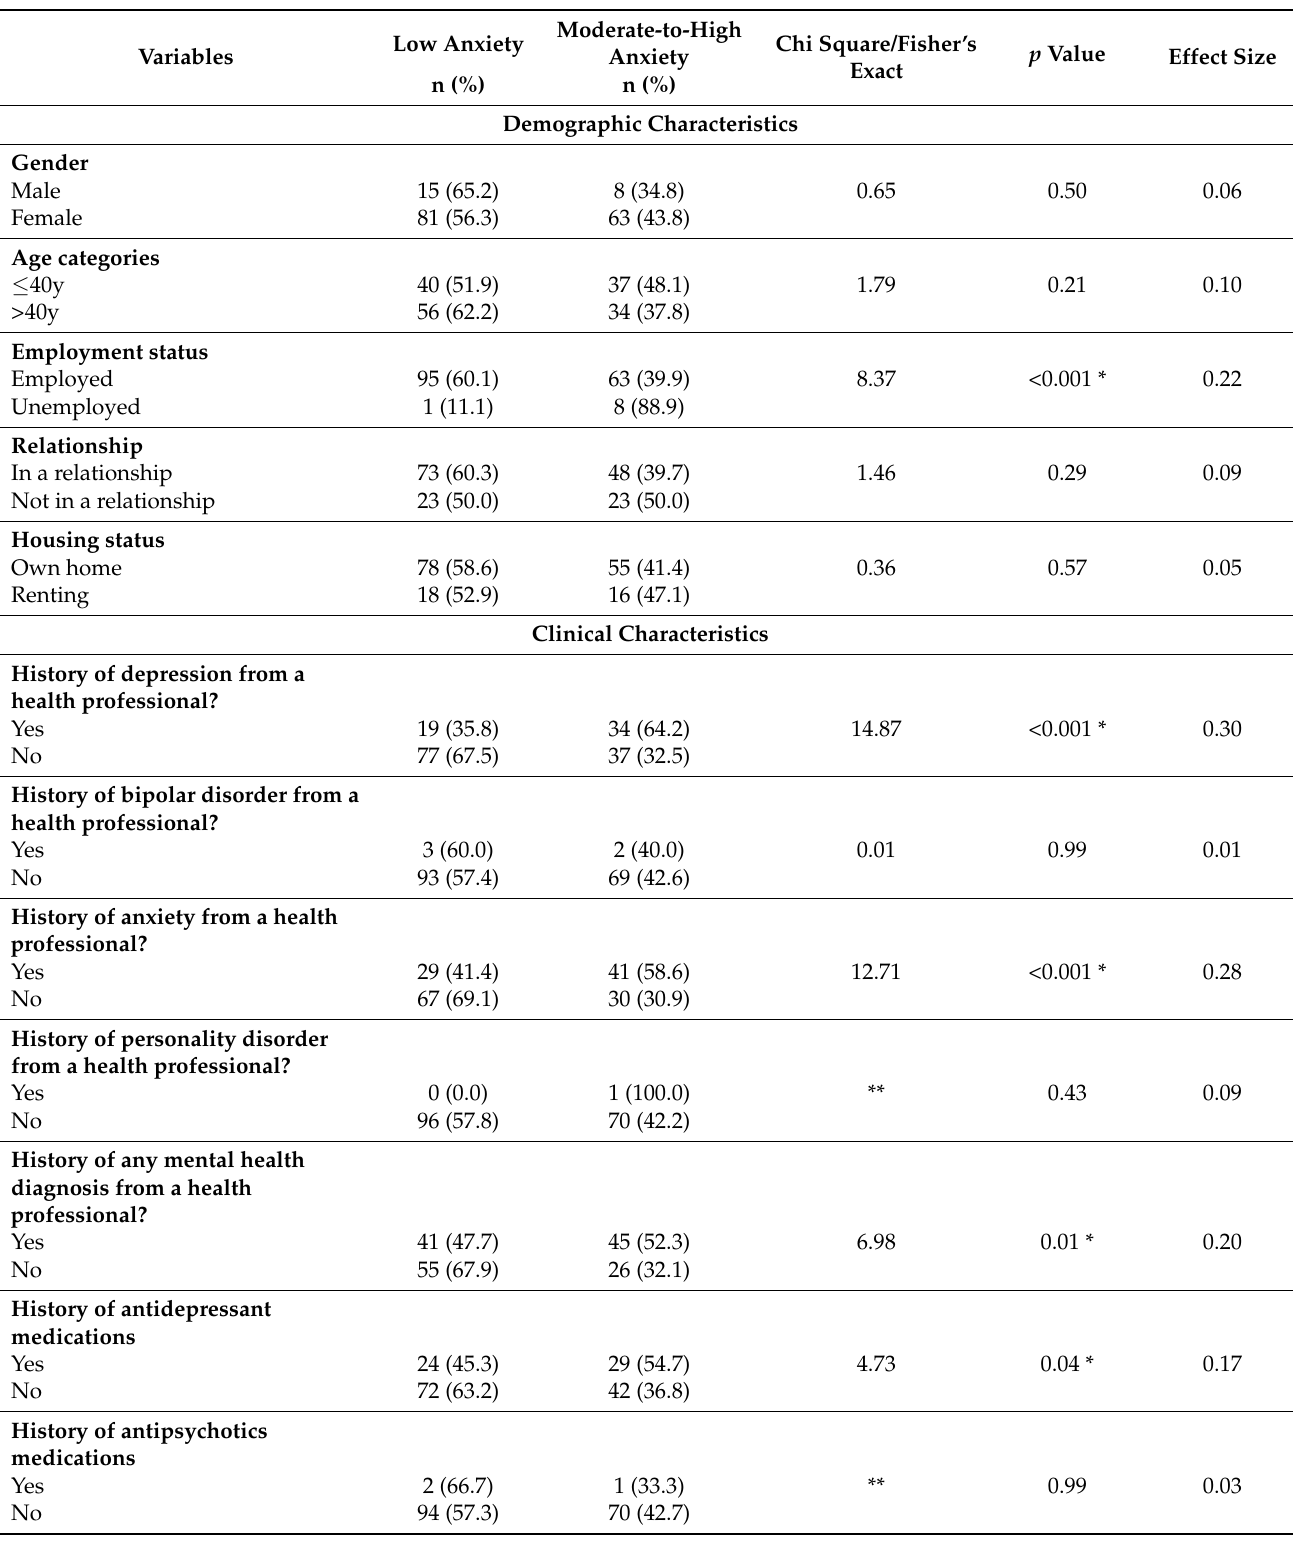
Table 2. Chi-squared test of association between demographic, clinical, and COVID-19 characteristics and likely